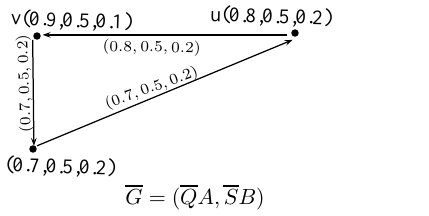
Table 9: Neutrosophic soft rough set on V V